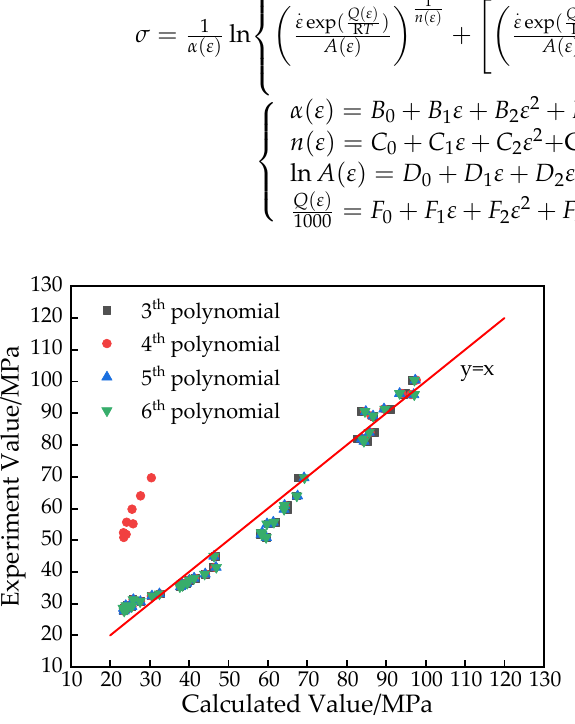
Figure 7. Experimental stress and calculated stress of different orders high quality 20MnCr5(SH) gear steel.